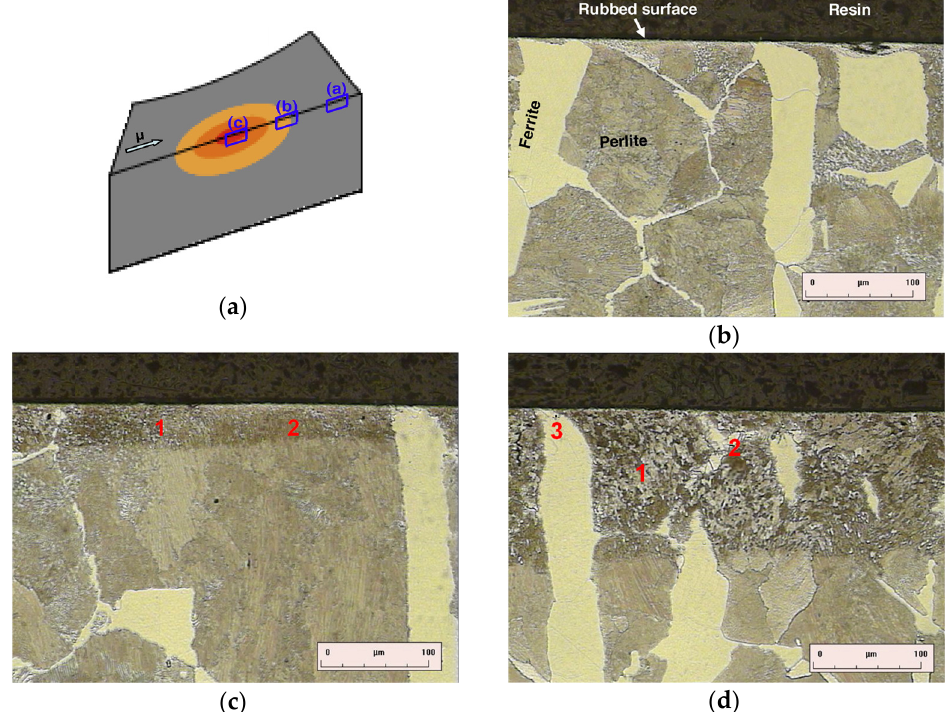
Figure 3. Images of the structure obtained with an optical microscope: ( a ) model of the target section with measurement points [10], ( b ) cross-section outside the overheating area [10], ( c ) cross-section on the edge of the overheating area [10], ( d ) cross-section directly in the overheating area: 1—bainite, 2—fine-grained perlite, 3—fine-grained ferrite [10].